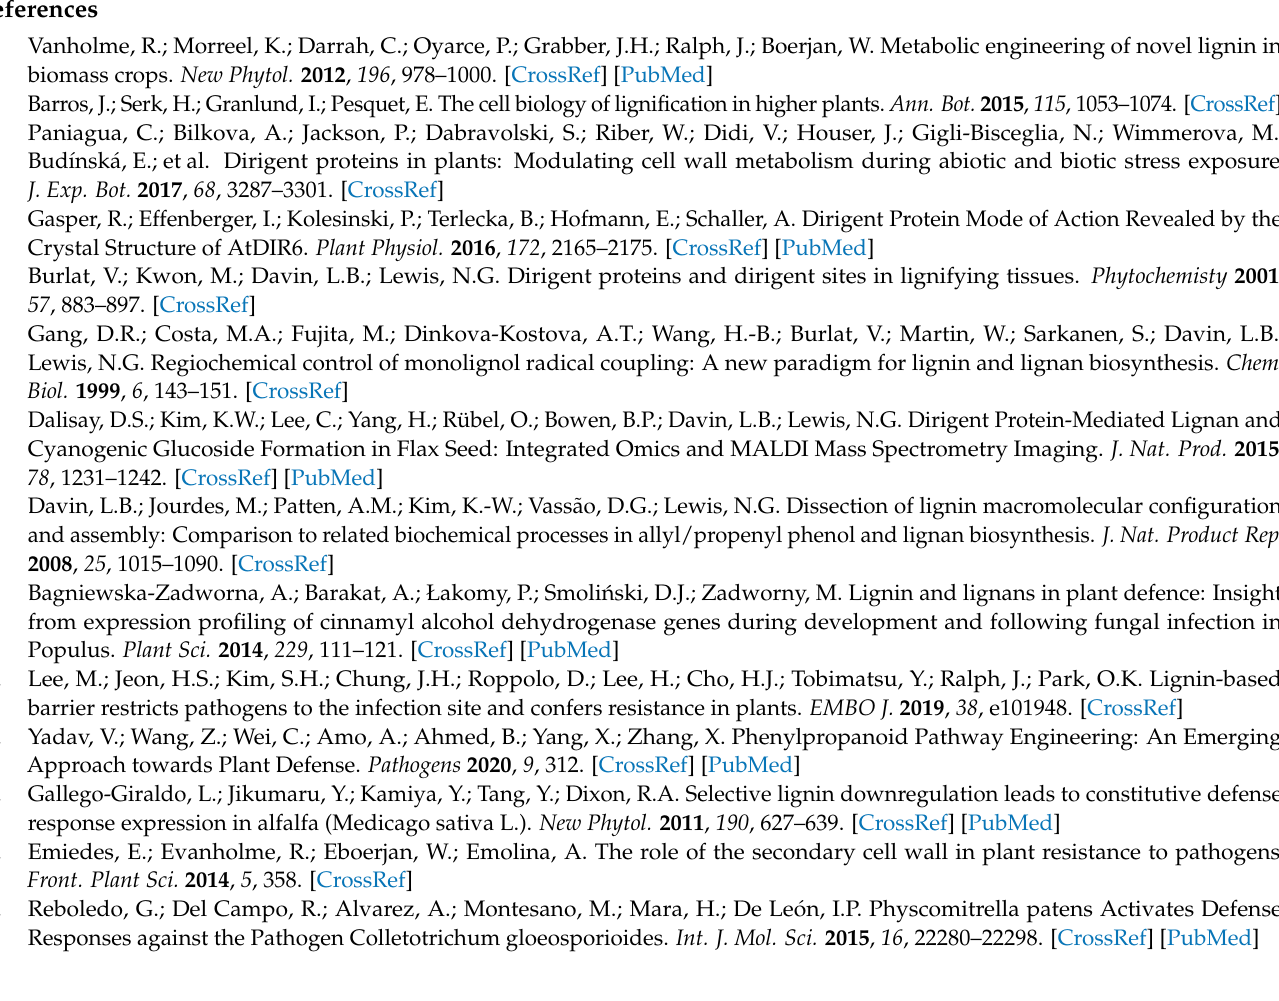
Table S3: Specific primers of ClDIR genes used for qRT-PCR in this